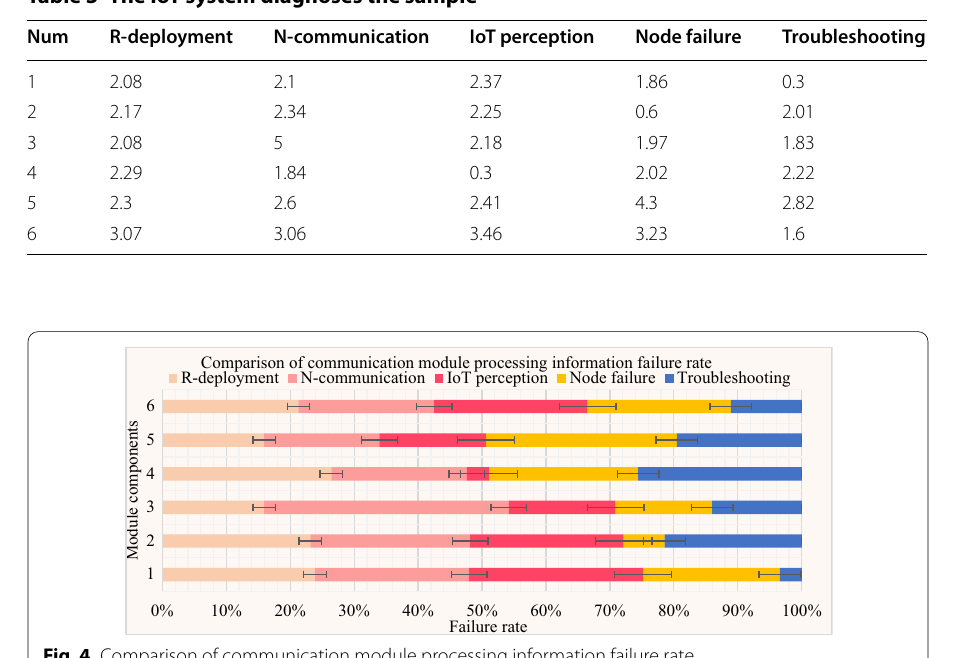
Fig. 4 Comparison of communication module processing information failure rate